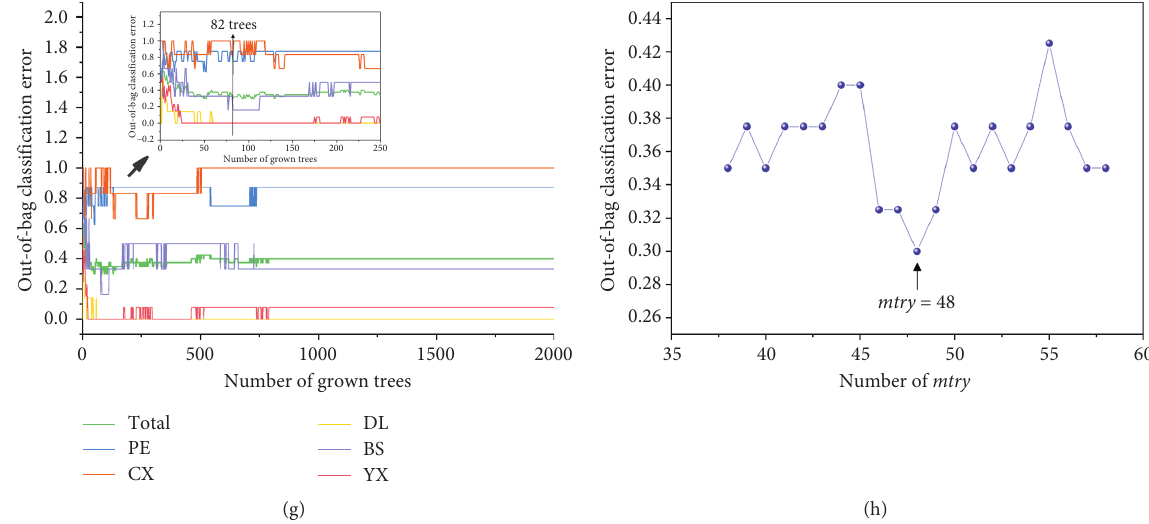
Figure 6: The n tree and mtry screening of the random forest models of independent decision making. AB: FTIR of cultivated samples; CD: LC of cultivated samples; EF: FTIR of wild samples; and GH: LC of wild samples.